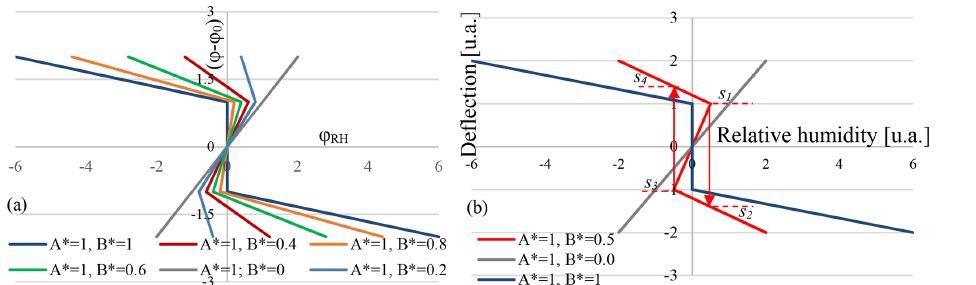
Figure 4. Calculated curves for (a) deflection s and (b) angle ϕ − ϕ 0 versus relative humidity ϕ RH . The switching points ( s 1 → s 2 ; s 3 → s 4 ) are marked.